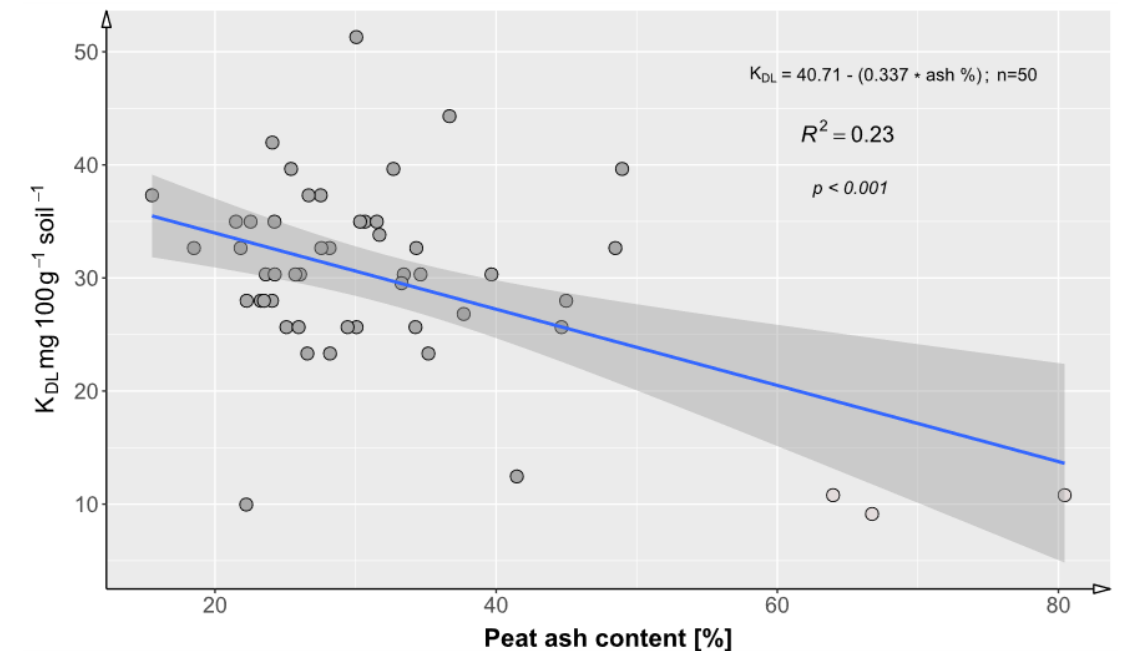
Figure 5. Relationship between peat ash content and K DL (n = 50). The blue line indicates the trend and the 95 % confidence interval is given by the grey